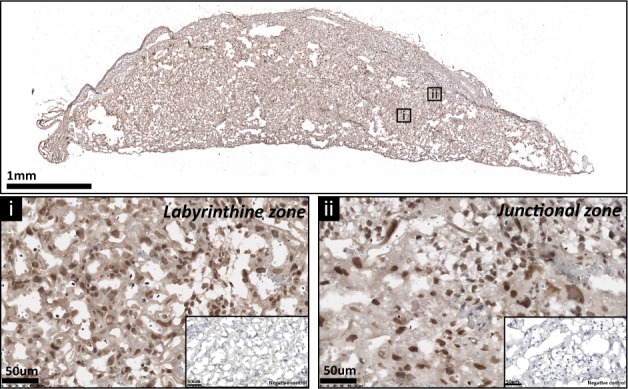
The expression of p110α protein by the mouse placenta on day 19 of pregnancy.Representative stained section shown with negative control shown in the figure inset.